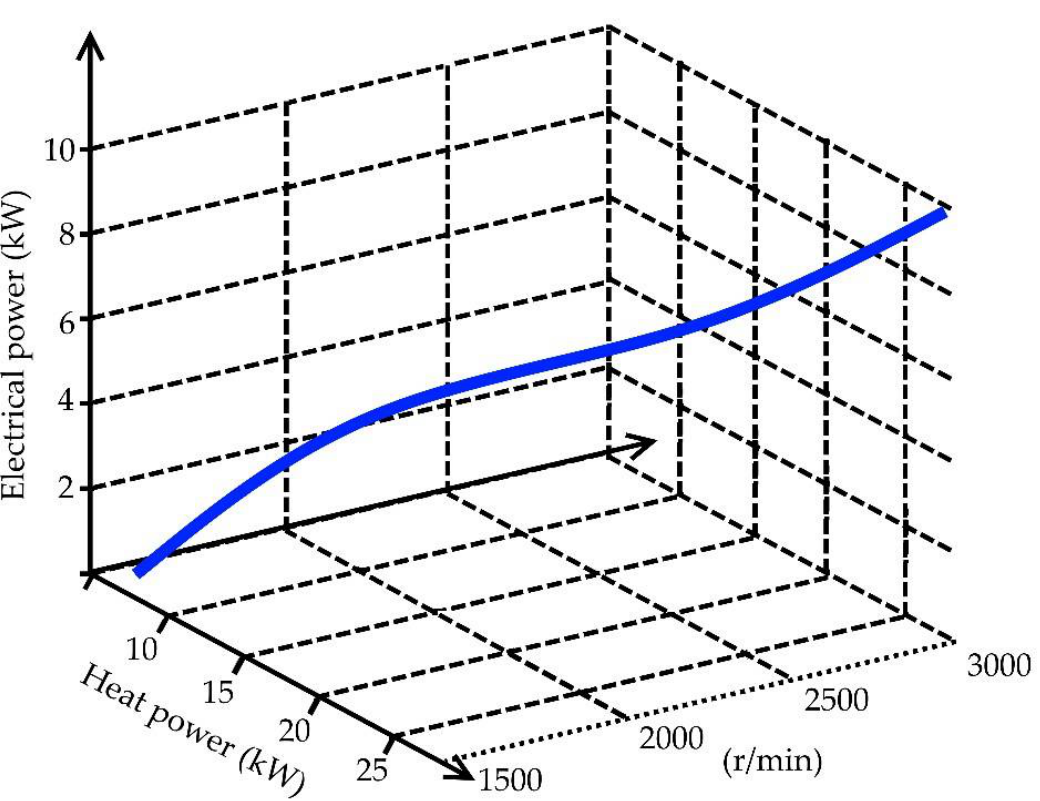
Figure 6. Electrical versus thermal power at variable rotational speeds of the generator.